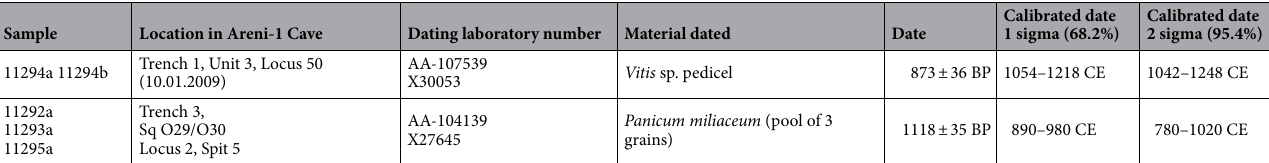
Table 2. Archaeological context and associated radiocarbon dates of broomcorn millet grains. AMS 14 C determinations for the millet from Areni-1were calibrated using OxCal v. 3.5 based on the last atmospheric dataset OxCal v.3.10 85 and IntCal13 86 .